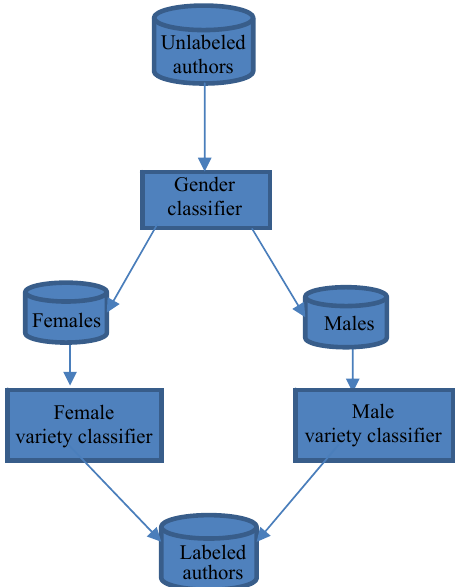
Fig. 5 Graphical illustration of successful classification [48] . Fig 5: Graphical Illustration of Successful Classification [47] Table 9 Gender classification results for loose classification [48] .